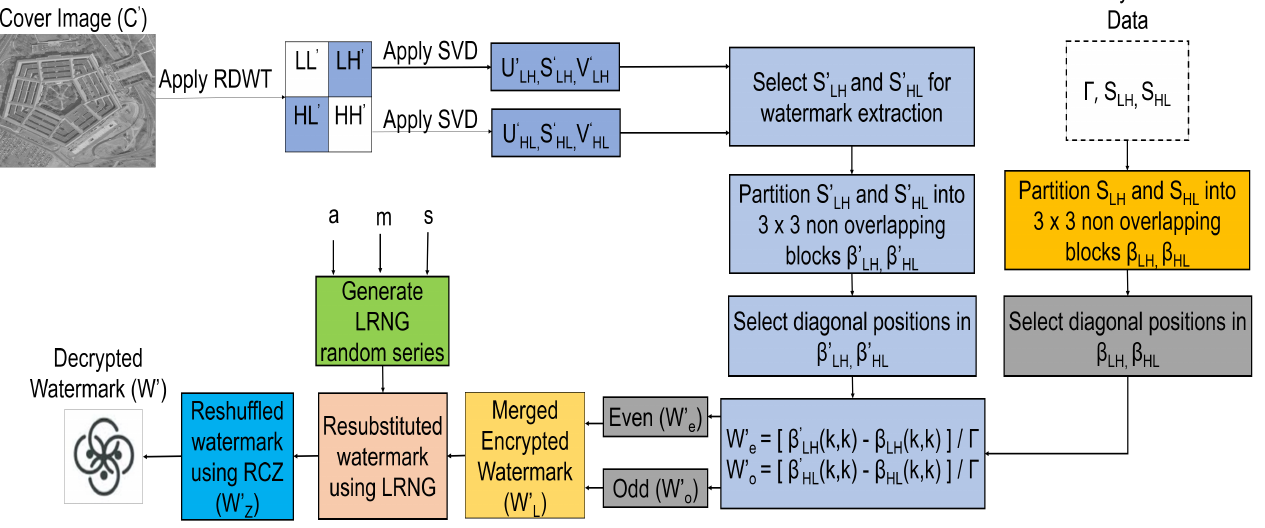
Figure 3. Block diagram for watermark extraction and decryption.